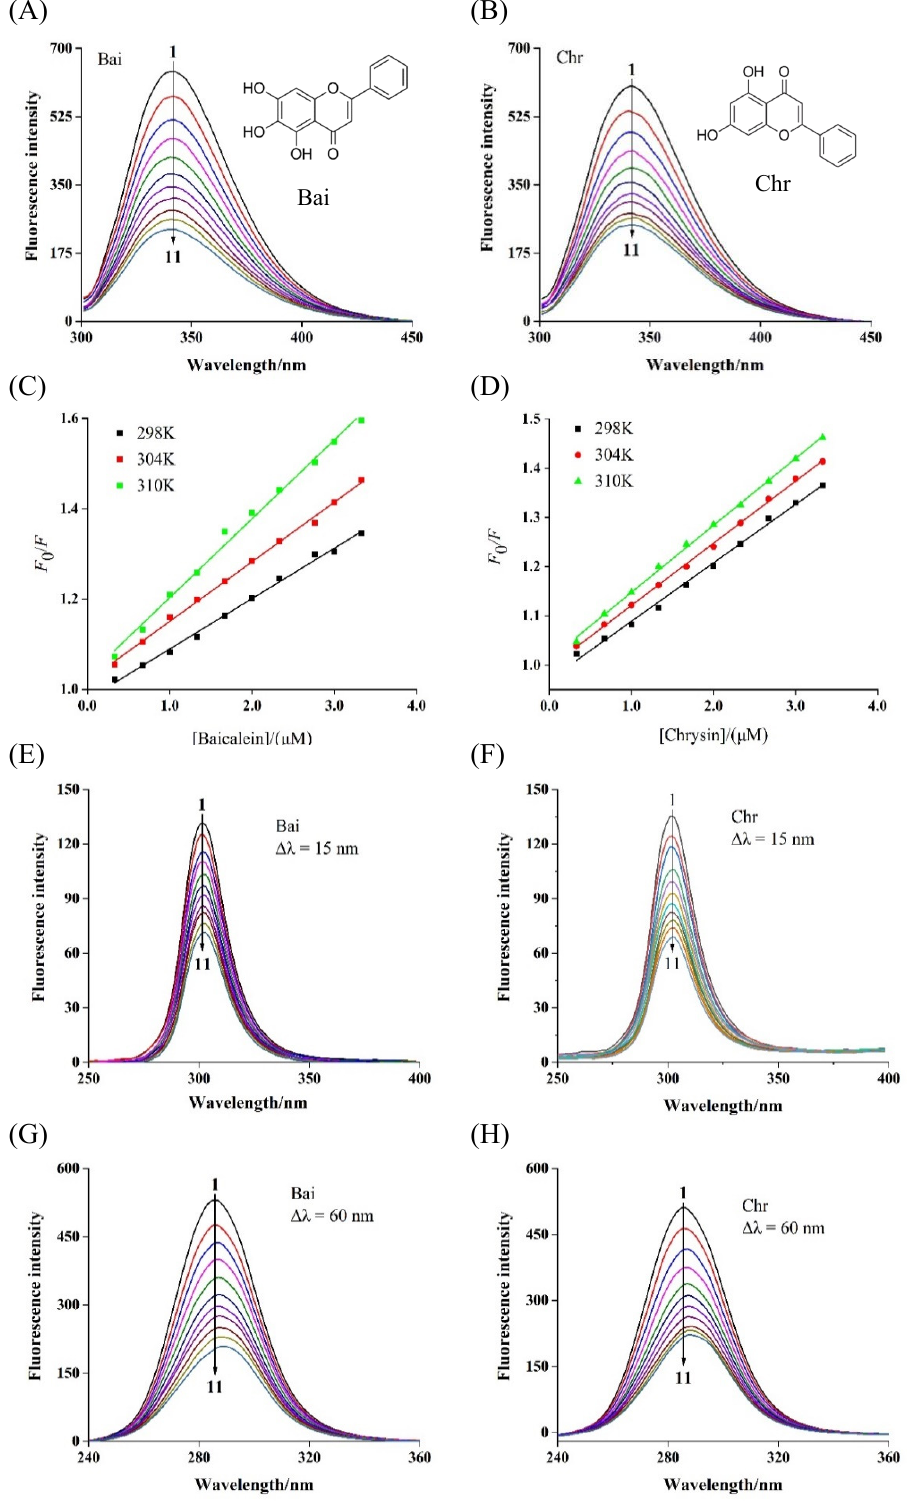
Figure 1. Fluorescence spectra of BLG in the presence of Bai ( A ) and Chr ( B ) at various concentrations, and the Stern–Volmer plots ( C , D ) at different temperatures ( T = 298 K, 304 and 310 K, pH 6.8, λ ex = 280 nm). c (BLG) = 20 µ M, c (Bai/Chr) = 0, 2.0, 4.0, 6.0, 8.0, 10.0, 12.0, 14.0, 16.0, 18.0, 20.0 µ M for Curves 1 → 11, respectively. Synchronous fluorescence spectra of BLG in the absence and presence of Bai and Chr (pH 6.8, T = 298 K). ∆ λ = 15.0 nm ( E , F ), ∆ λ = 60.0 nm ( G , H ). c (BLG) = 20.0 µ M, c (Bai/Chr) = 0 to 20.0 µ M for Curves 1 → 11,